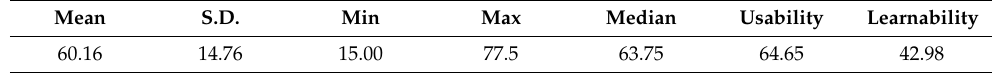
Table 5. SUS scores: target group.